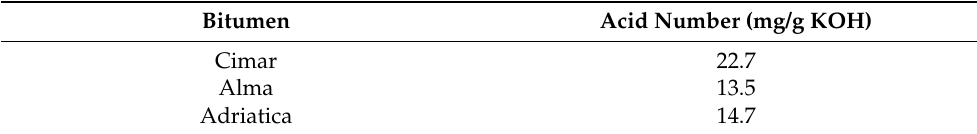
Table 2. Acid number for each sample.